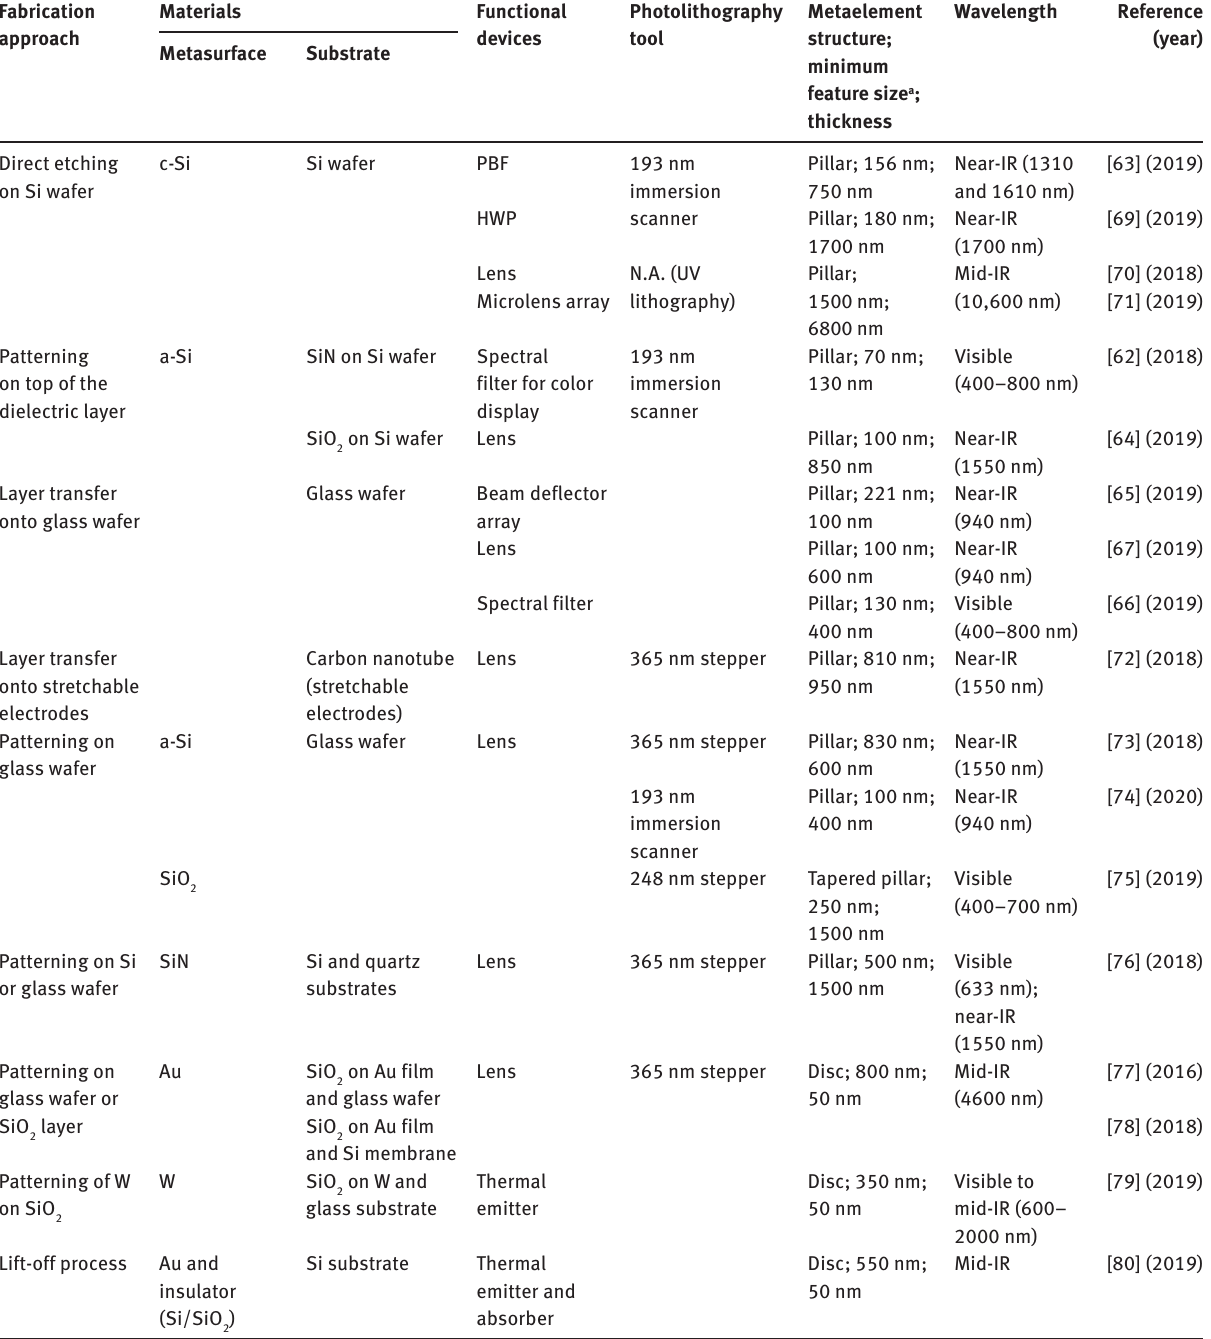
Table 1: Summary of metasurface-based devices patterned using photolithography.